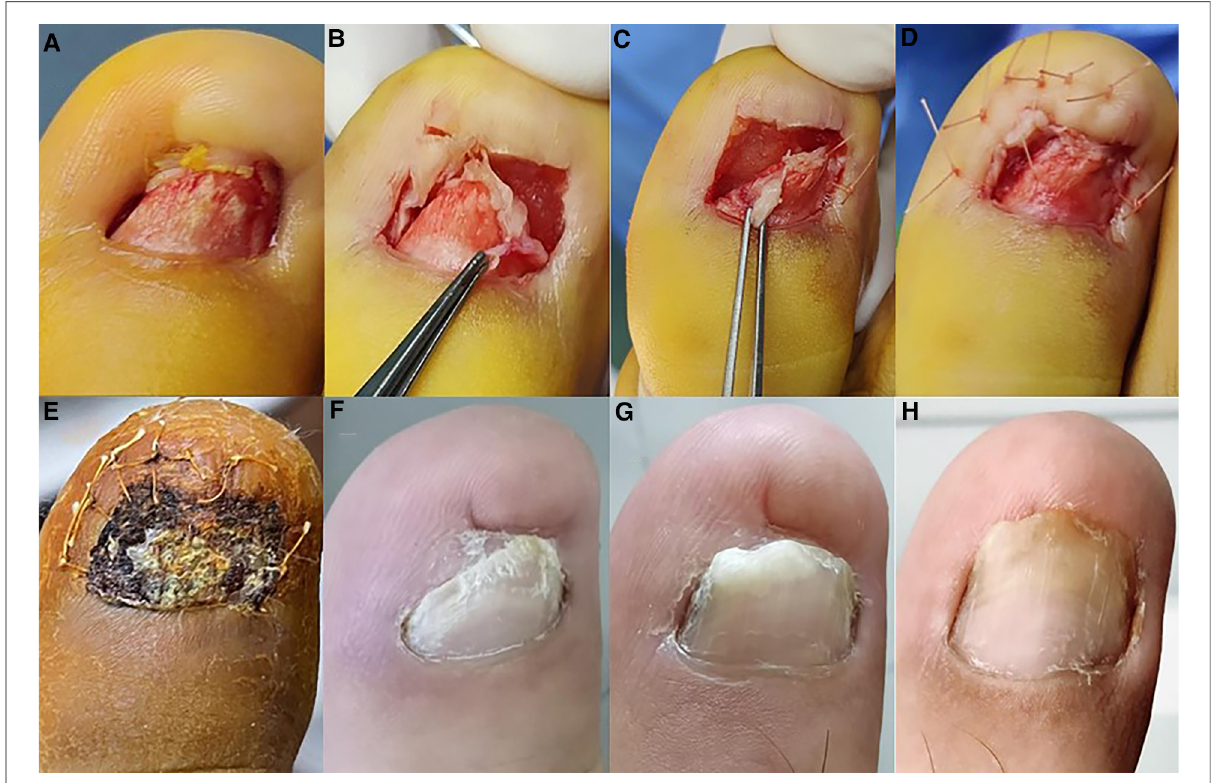
FIGURE 3 Toenail bed was embedded before surgery ( A ). Arti fi cial dermis was fi lled on both sides of the affected toe ( B ). After the arti fi cial dermis fi lling, the nail bed was obviously smooth ( C ). Postoperative appearance of the affected toe ( D ). Appearance of the affected toe 1 month after surgery ( E ). Appearance of the affected toe 3 months after surgery ( F ). Appearance of the affected toe 9 months after surgery ( G ). Appearance of the affected toe 1 year after surgery ( H